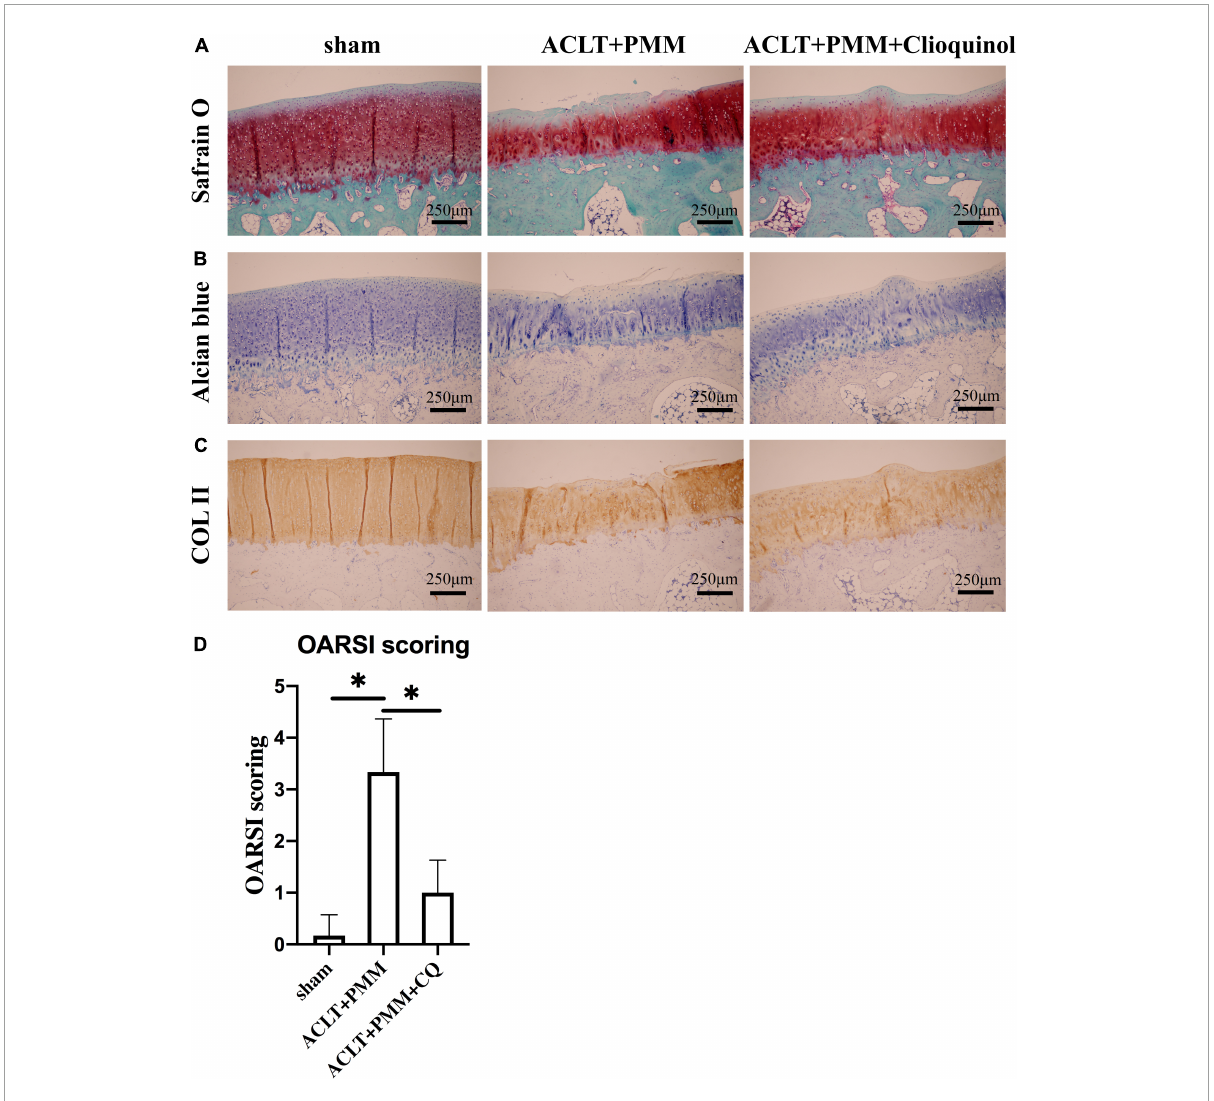
FIGURE4 Clioquinol ameliorates osteoarthritis (OA) development in rabbit model. (A,B) Representative Safranin O-Fast green and Alcian Blue staining of cartilage in three groups ( n = 6) at the 8th weeks post-surgery. (C) Representative IHC staining showing the expression and distribution of Col-2a1 in cartilage after treatment. (D) Cartilage degeneration evaluated by OARSI scoring system. All data are shown as the mean ± SD. ∗ p <